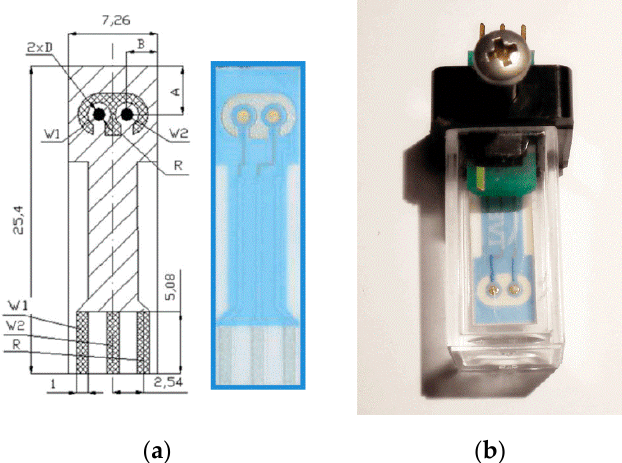
Figure 13. Images of the original AC2P.W1 sensor ( a ) and the modified sensor in a cuvette ( b ). The diameter of the spot electrodes is 1 mm, and the distance between their centers is 2.5 mm.